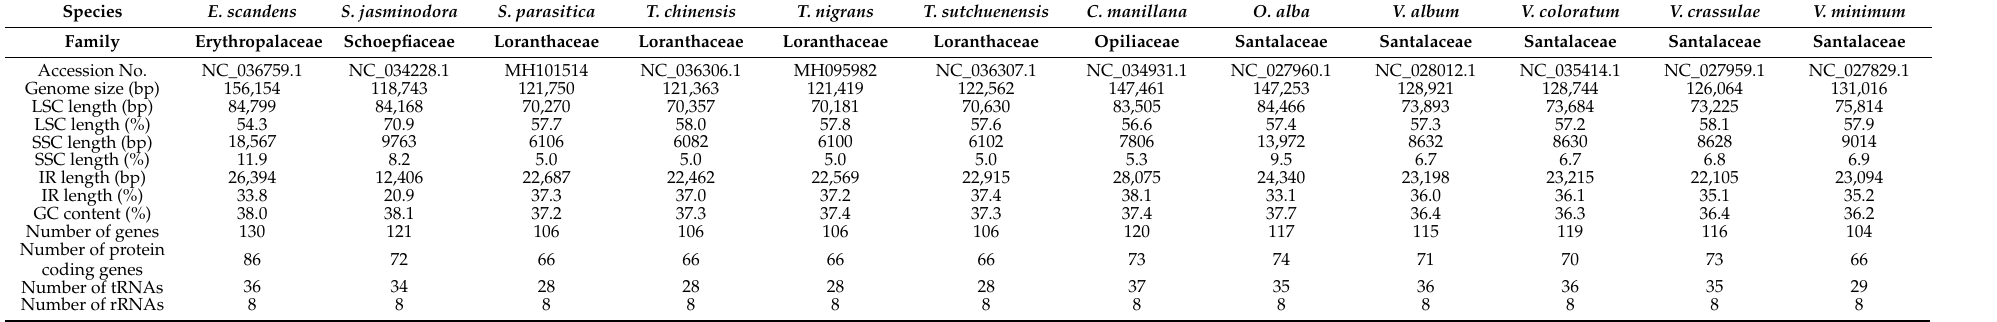
Table 3. Comparative Chloroplast Genomic Analysis in